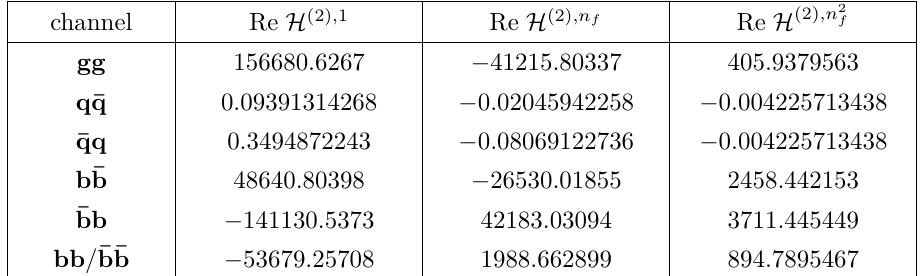
Table 5. Numerical values of the two-loop reduced squared finite remainders H (2) defined in eqs. (6.3)–(6.9) at the kinematic point in eq. (6.11) for the various closed fermion loops contributions and the scattering channels specified in eq.